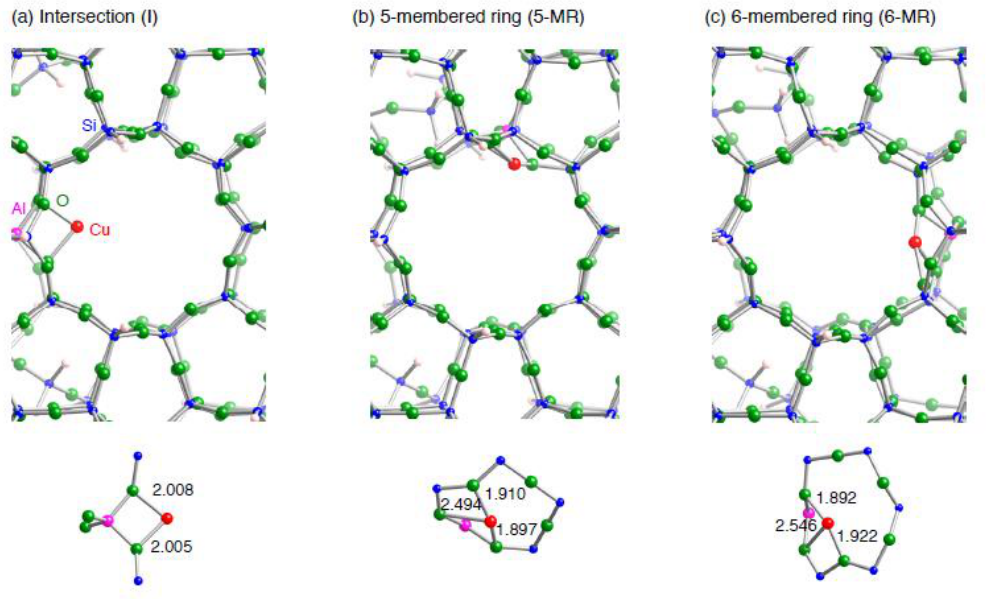
Figure 3. Local structures of three optimized structures for a monocopper cation sitting inside the AlSi O H ZSM-5 model. (a) the copper cation sits at the intersection 91 151 66 between a straight and a zigzag channel, denoted by I . (b) the copper cation sits above a 5-membered ring of a wall along a straight channel, denoted by 5-MR . (c) the copper cation sits above a 6-membered ring of a wall along a straight channel, denoted by 6-MR